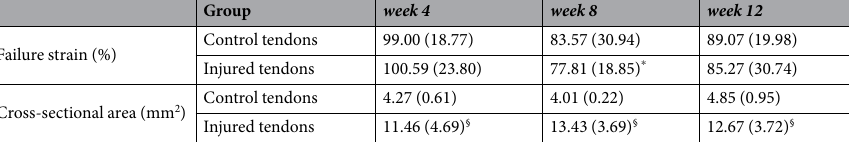
Table 1. Failure strain and cross-sectional area values. Values are expressed as means ± standard deviation. § compared with the control tendons; * significant difference between week 4 and week 8 in the injured tendons; §/ * p < 0.05.